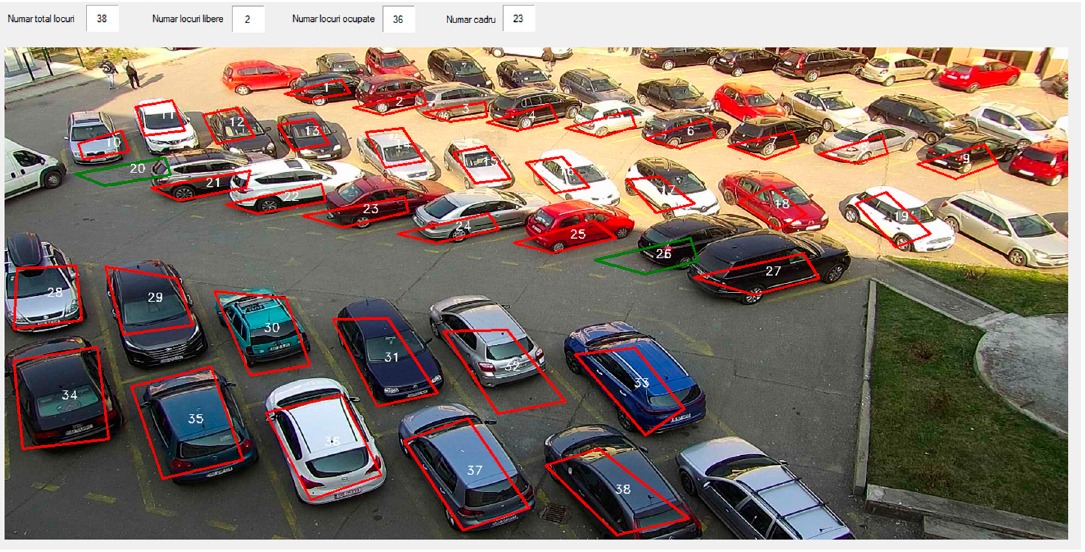
Figure 9. A result sample from benchmark 1.